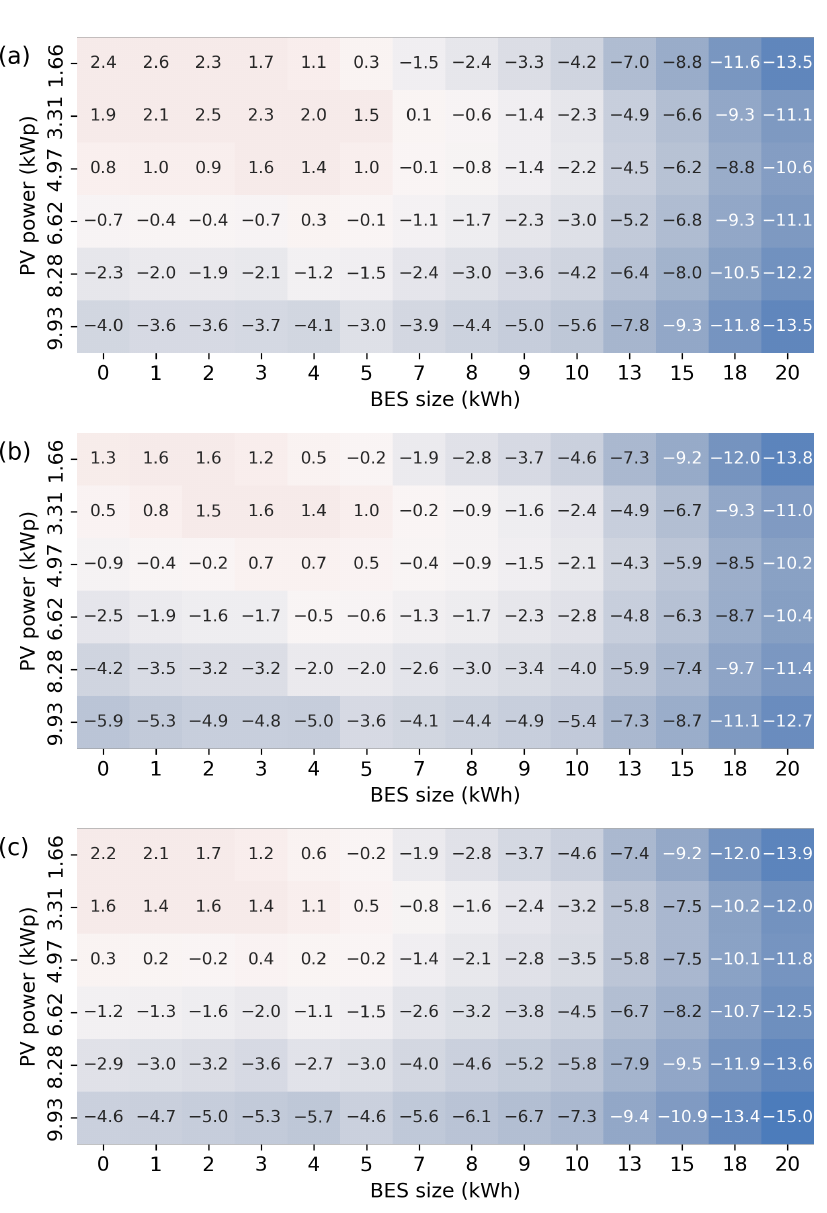
Figure 5. Heatmaps of NPVs ( × £1000) for different PV power and BES sizes for the example consumer in the future cost scenario for all tariffs. ( a ) NPVs for the Agile tariff in the future scenario. ( b ) NPVs for the ToU tariff in the future scenario. ( c ) NPVs for the Std tariff in the future